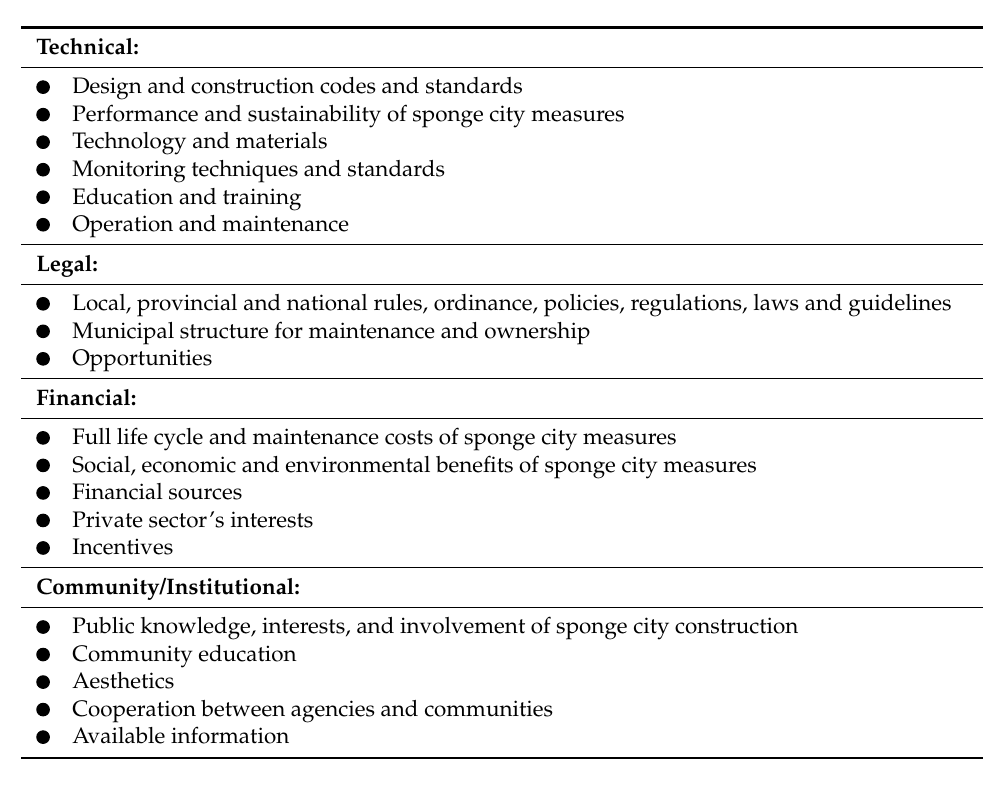
Table 1. The outline of the survey